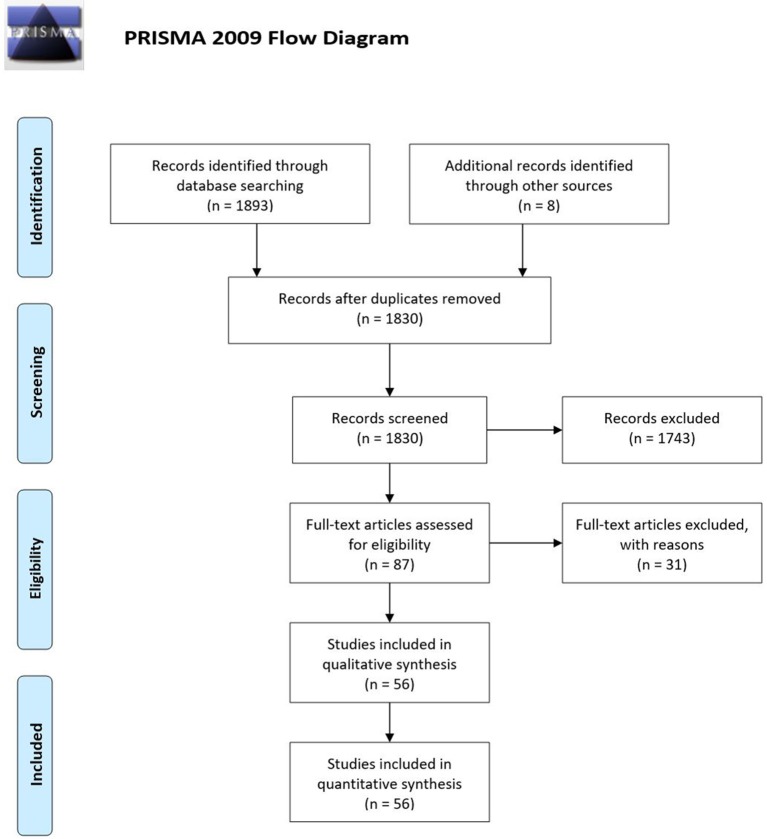
Prisma flow diagram.